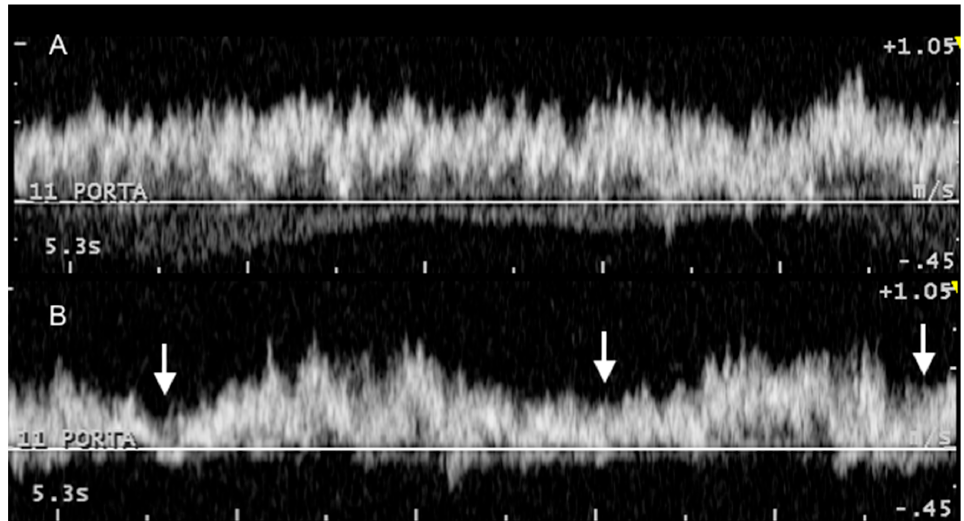
Figure 5. Variation in Doppler phasicity of the portal vein at rest ( A ) and with deep respiratory movements ( B ), obtained consecutively in the same animal and anatomical point (11 intercostal space). White arrows indicate inspiration movements.